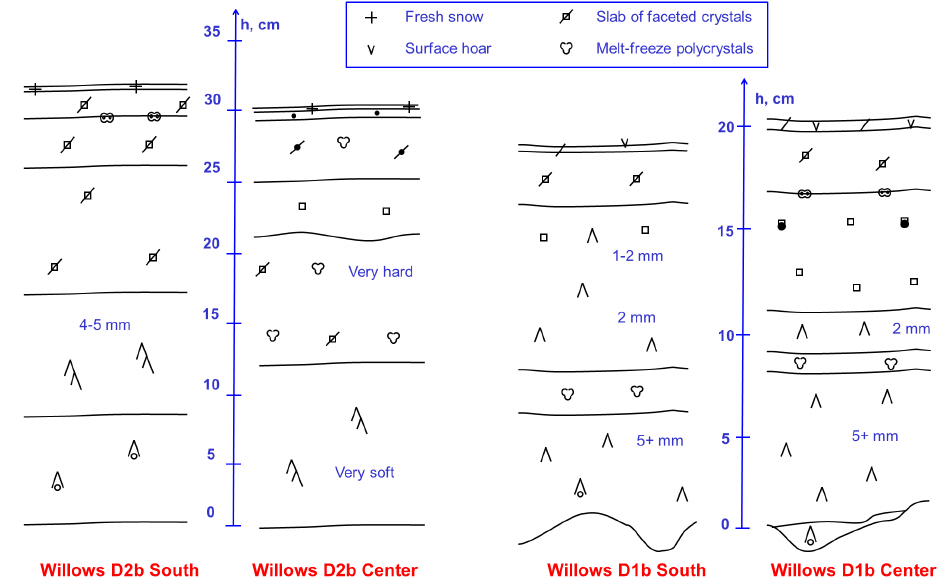
Figure 6. Simplified snow stratigraphy in isolated willow bushes. Two stratigraphies in the center of the bush and to the south (uphill) of bushes, about 1m from the nearest shrub, are shown. Note the different vertical scales for both sites. The size (largest dimension) of depth hoar crystals is indicated. Only symbols not shown in Fig. 4 are